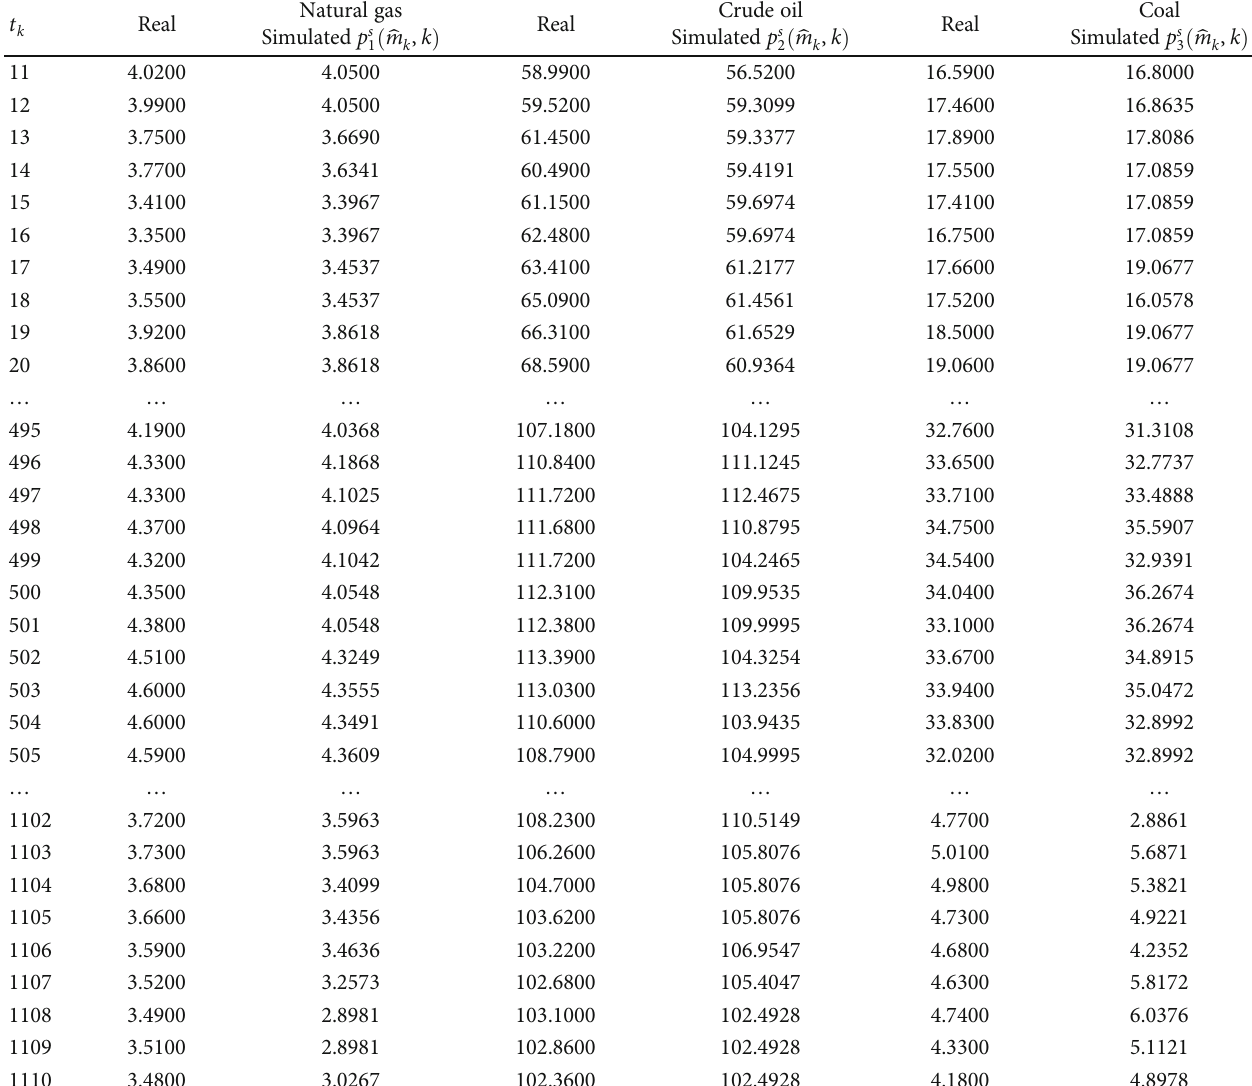
Table 5: Real and simulated estimates (without jump) for natural gas, crude oil, and